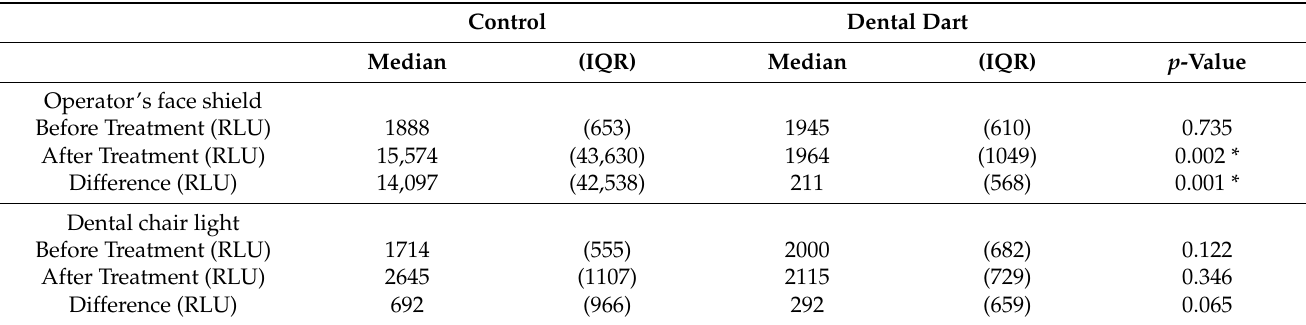
Table 1. Changes in the ATP value during dental treatment (* means p < 0.05).